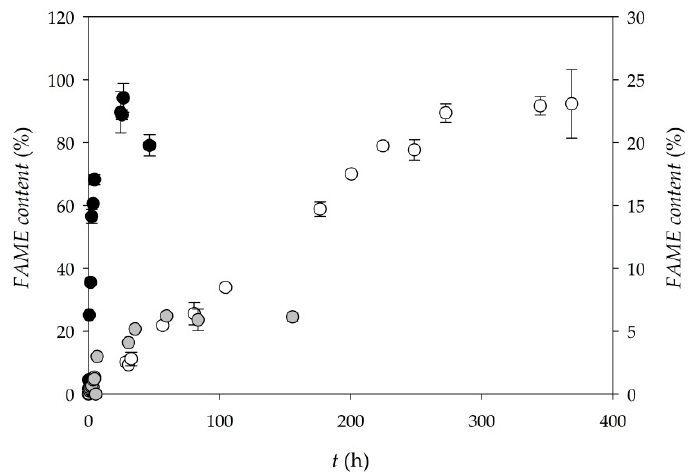
Figure 4. Fatty acids methyl esters (FAME) content when the reaction is performed by using ( ● ) commercial, ( ○ ) unpurified and ( ● ) purified enzyme ( ○ and ● are presented on the secondary axis).